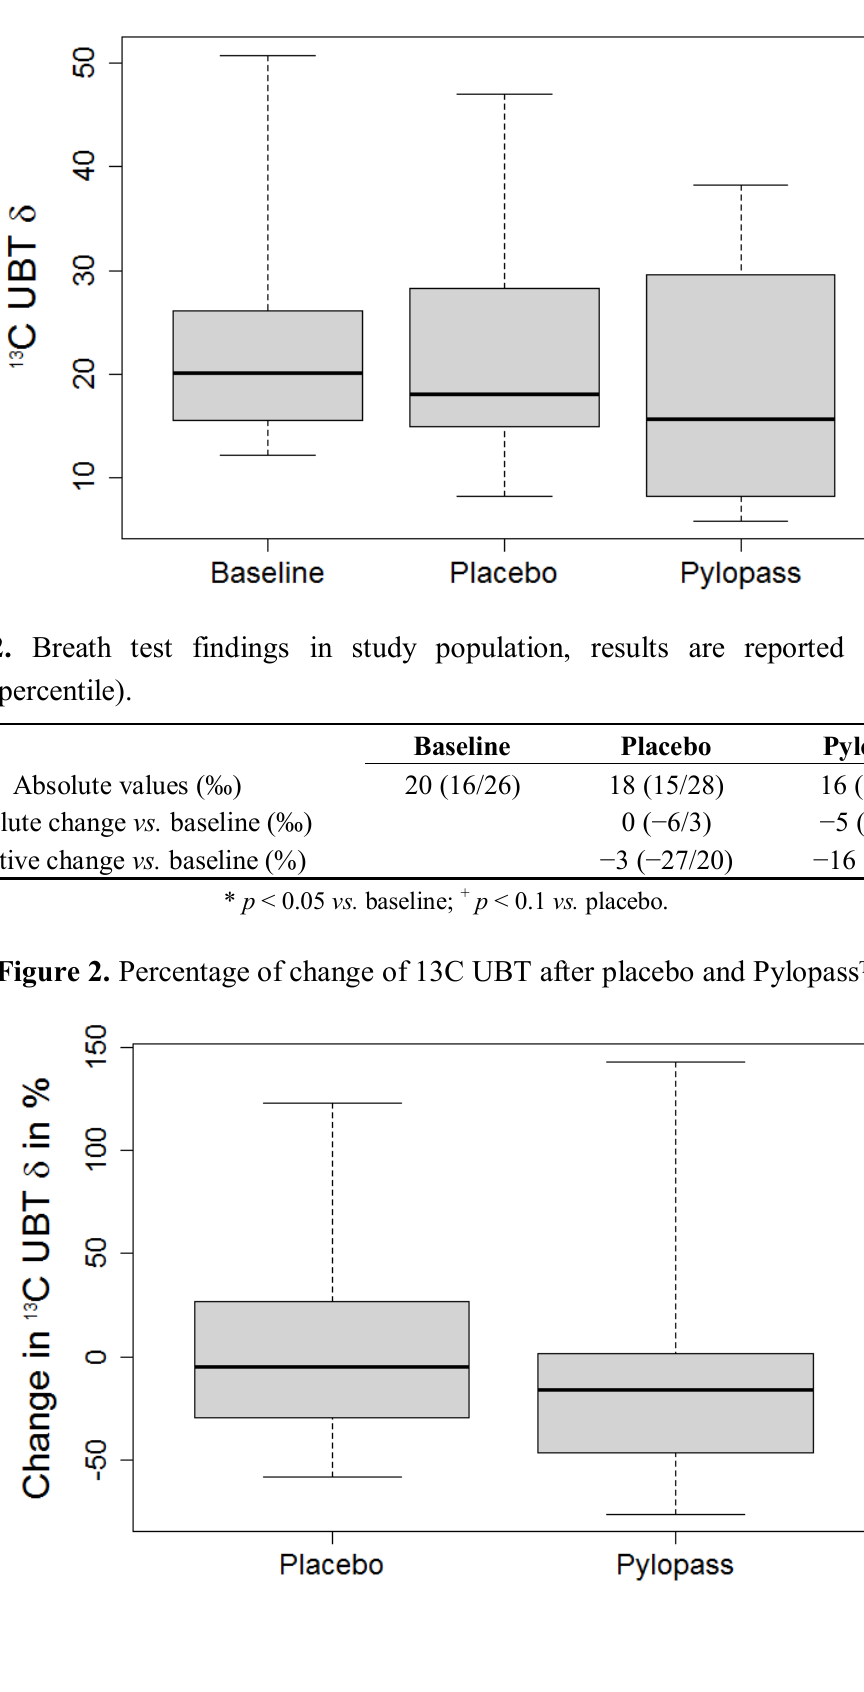
Figure 1. Absolute 13 C-urea breath test (UBT) values before and after supplementation with placebo or Pylopass™.